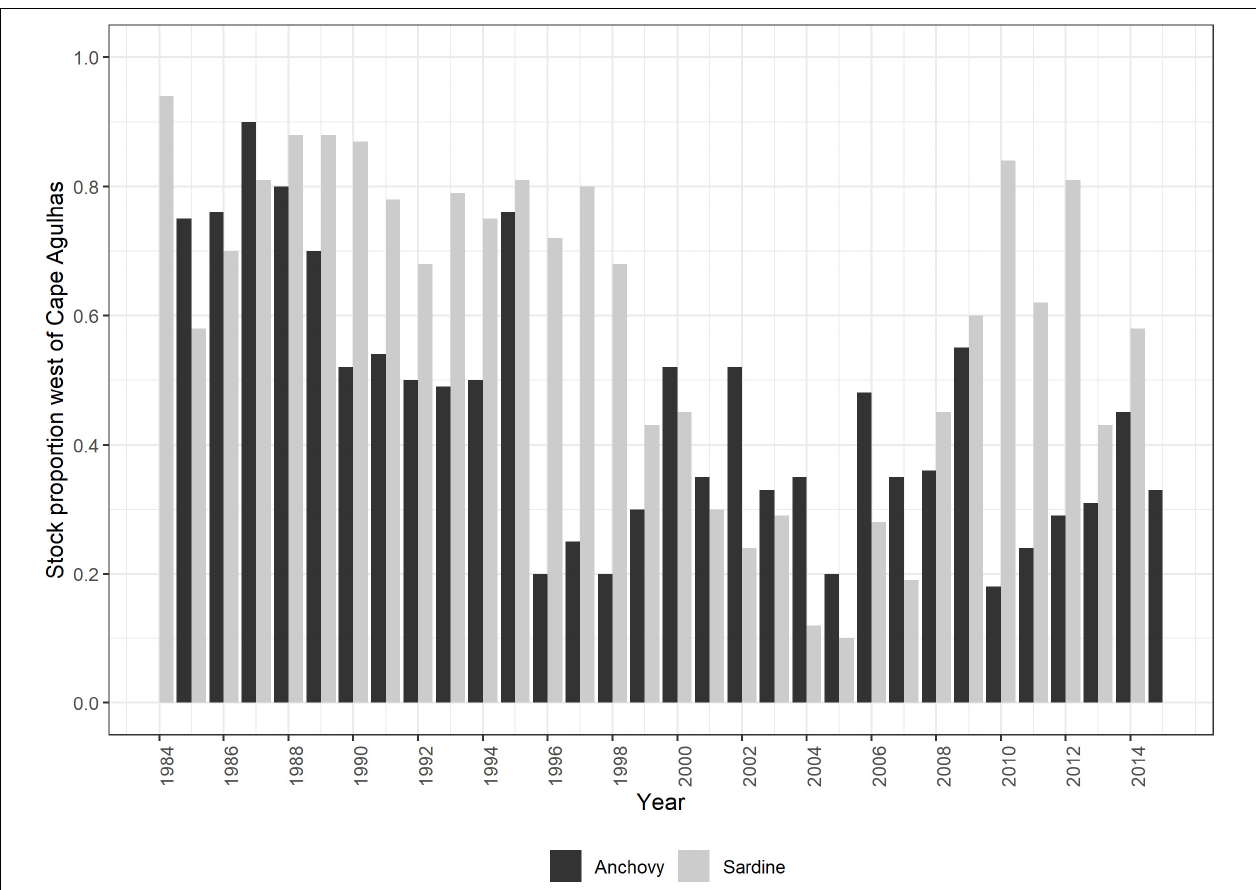
FIGURE 3 | Relative proportion of the total spawner biomass found to the west of Cape Agulhas: based on November survey biomass series for anchovy (from Figure 1 of FISHERIES/2016/JUL/SWG-PEL/22REV2) and model-predicted sardine south coast component in November each year (based on the aforementioned divided by survey bias, Carryn de Moor, personal